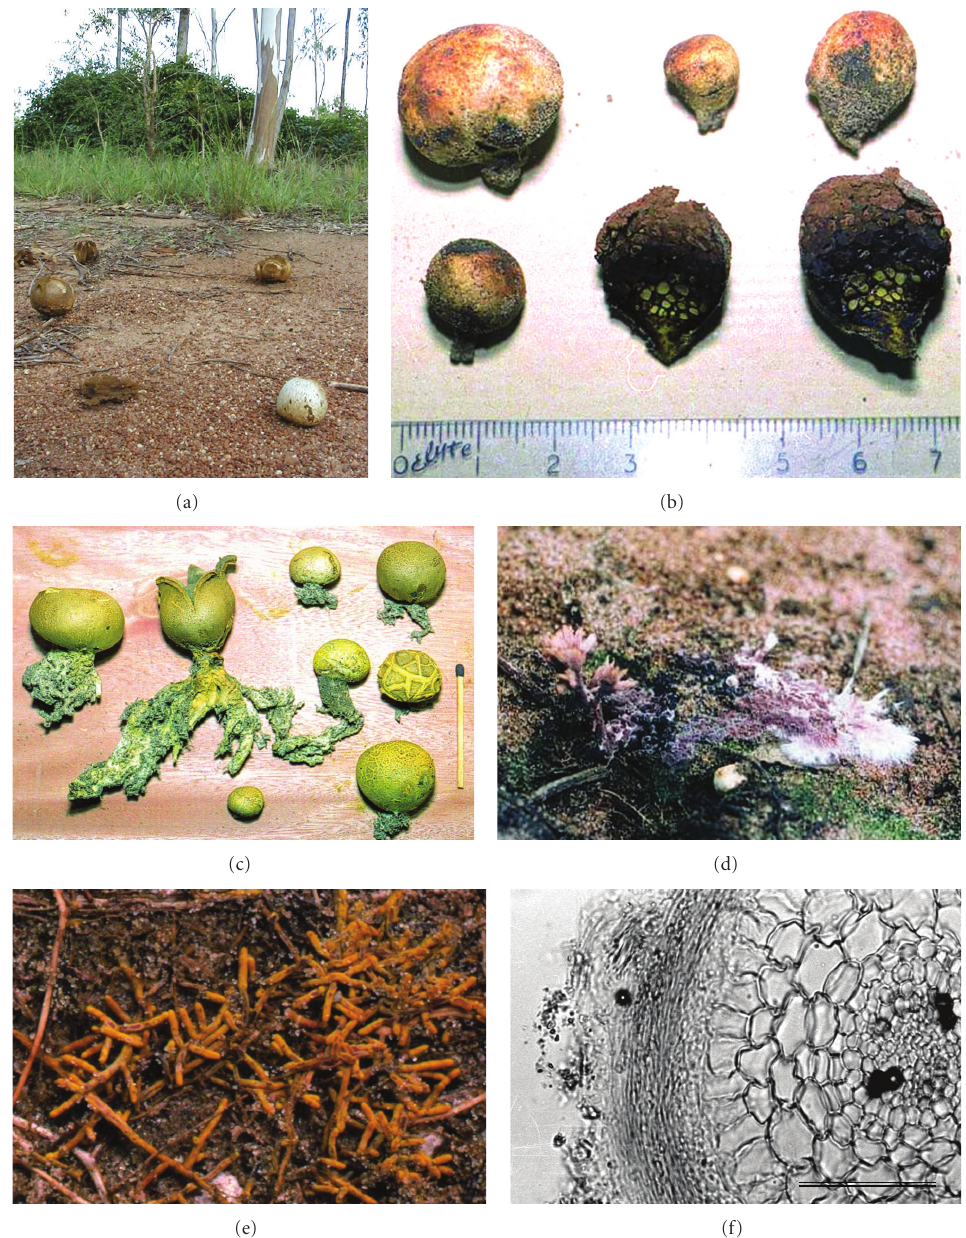
Figure 1: Example of ectomycorrhizal fungi and ectomycorrhizae of eucalypts in Africa. (a) Pisolithus albus ; (b) Pisolithus marmoratus ; (c) Scleroderma flavidum ; (d) Thelephora sp.; (e) golden yellow ectomycorrhizae of Pisolithus albus with E. camaldulensis ; (f) cross-section of an ectomycorrhizae of Pisolithus albus with E. camaldulensis . The bar represents 50 µ